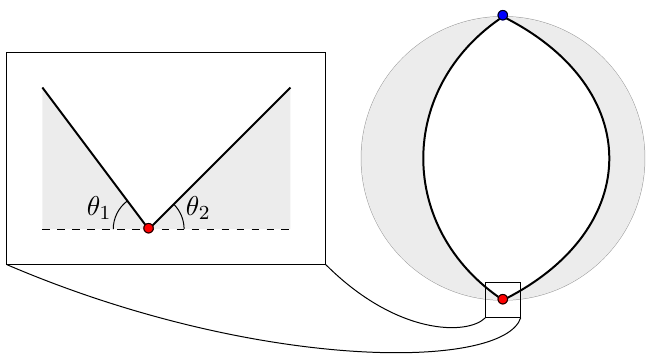
Figure 4. The empty AdS 3 wedge consisting of two KR branes. Here we show both the global picture and the Poincaré patch (which is one-point compactified to the global picture). While the defect in the Poincaré patch appears to be a point (which only has the time